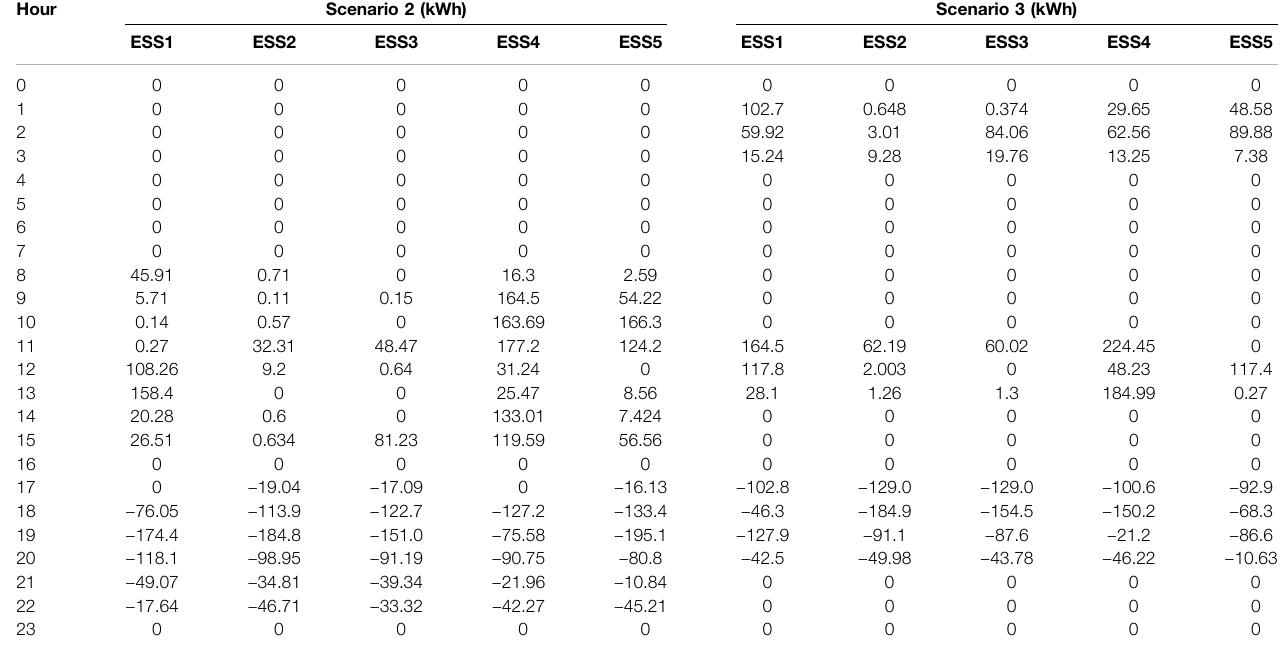
TABLE 1 | Charging and discharging results of BESS in Scenario 2 and Scenario 3.